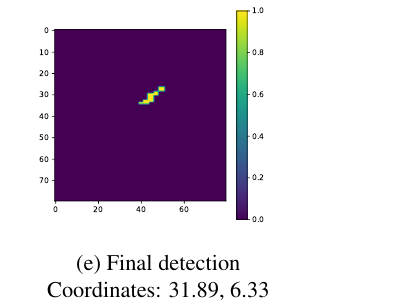
Figure 10. On all images, pixels in white are discarded pixels (cloudy for example). In (a), the L2 data with a methane plume in the middle of the image. On the other figures, the evolution of at each step of the algorithm. the coefficient x CH 4